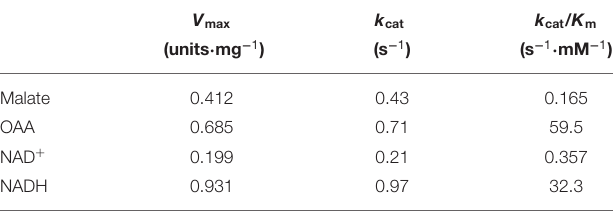
TABLE 1 | Kinetic parameters of Sy MDH.